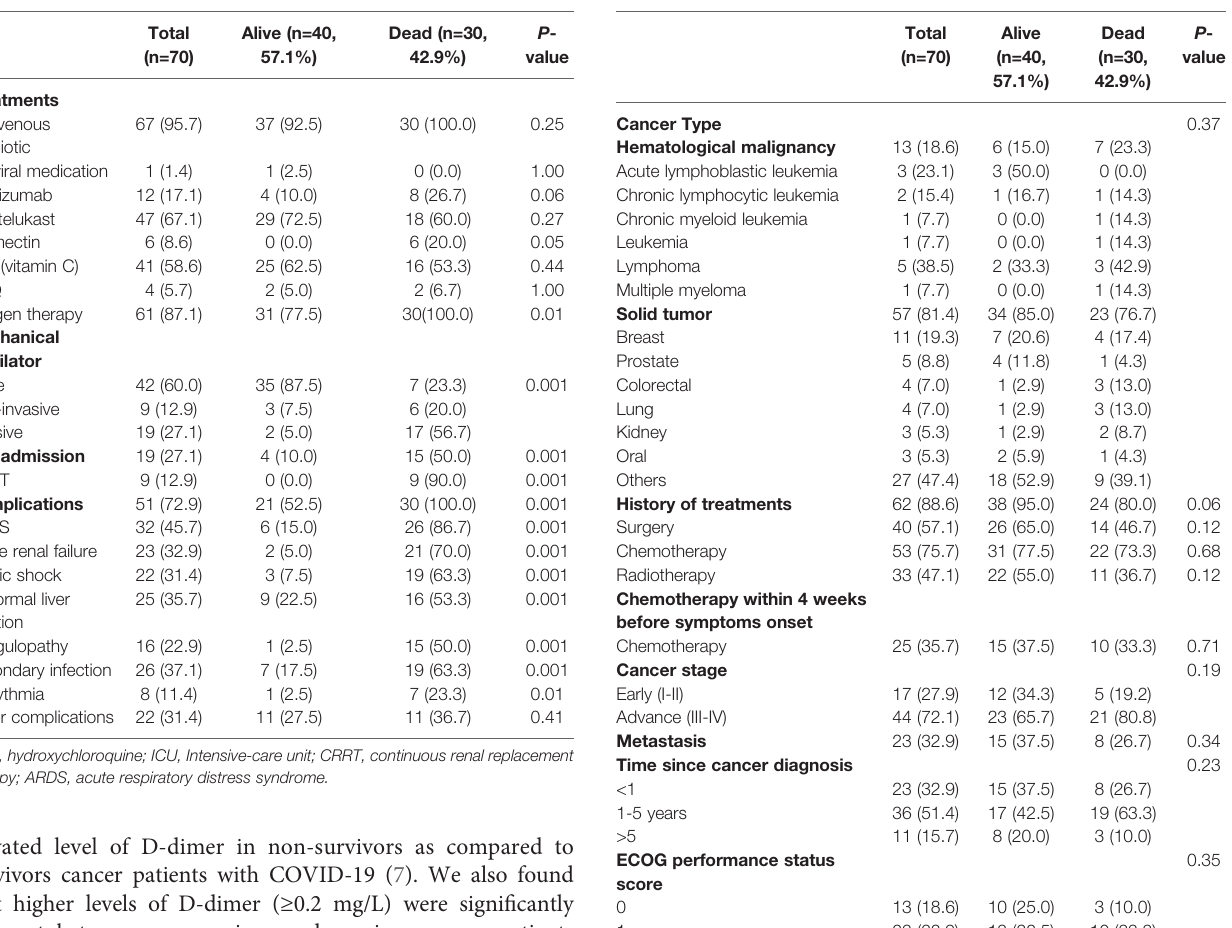
TABLE 3 | Treatments and complications of patients with cancer and COVID-19. TABLE 4 | History of cancer in patients with